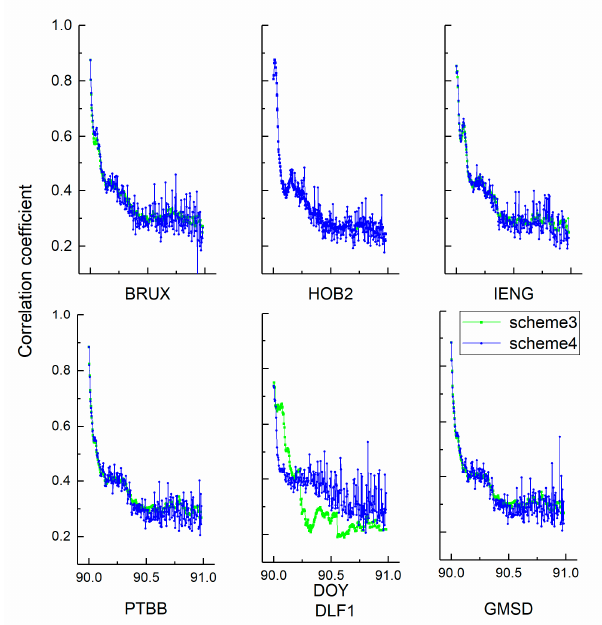
Figure 4. The correlation coefficients between the static receiver clock offsets and height position estimates.